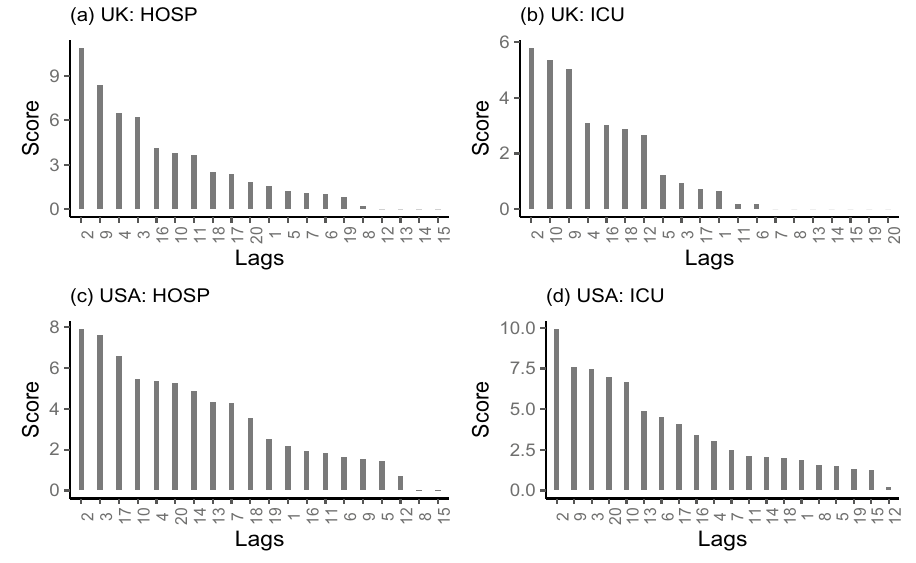
Figure 6. Average feature importance scores computed from 500 replications of RF model of (cid:31) HOSP t and (cid:31) ICU t for distributed lags of (cid:31) VAC t − k in USA and UK, where k = 1, . . . , 20 .